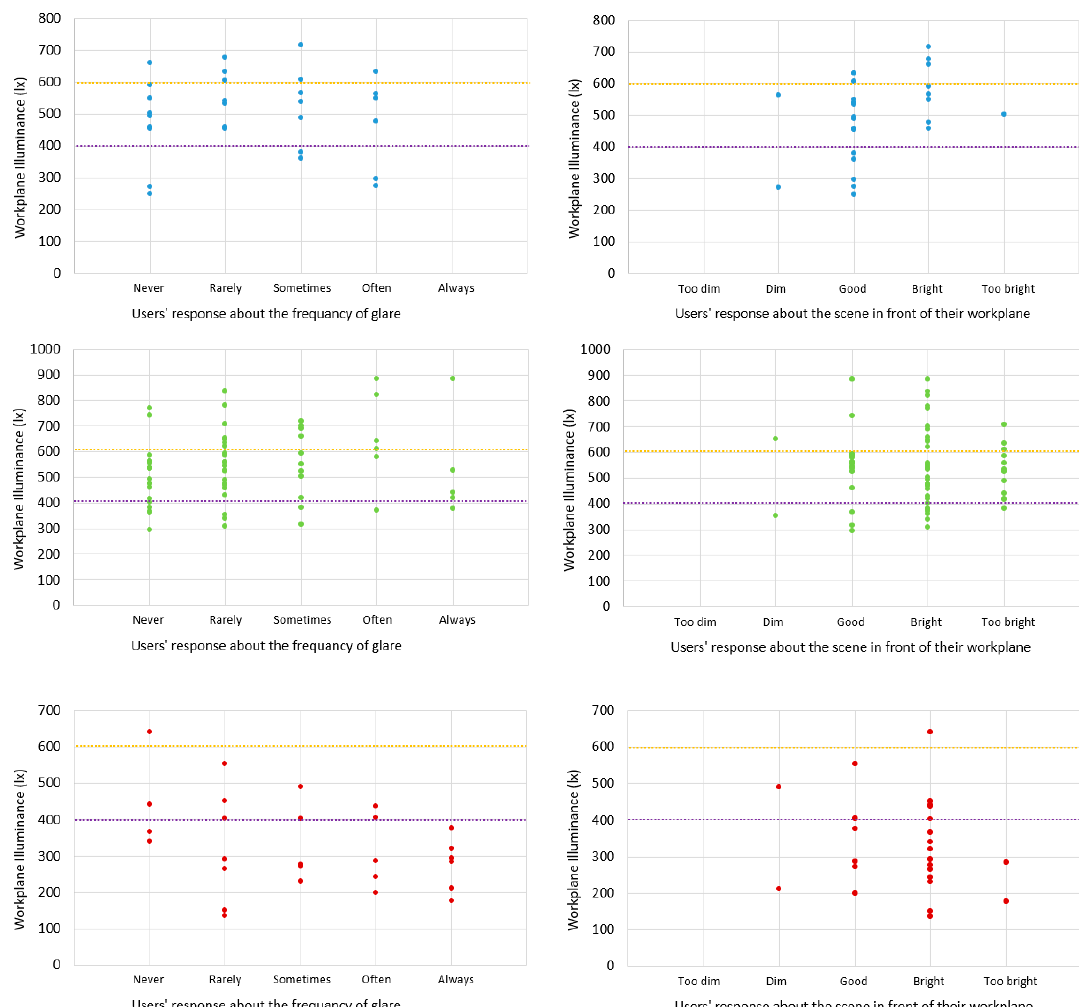
Figure 18. Responses about the frequency of glare (left column) and the brightness of the scene in front of their working plane (right column) in relation to the measured illuminance (Building A: Upper part, Building B: Middle, Building C: Lower part).